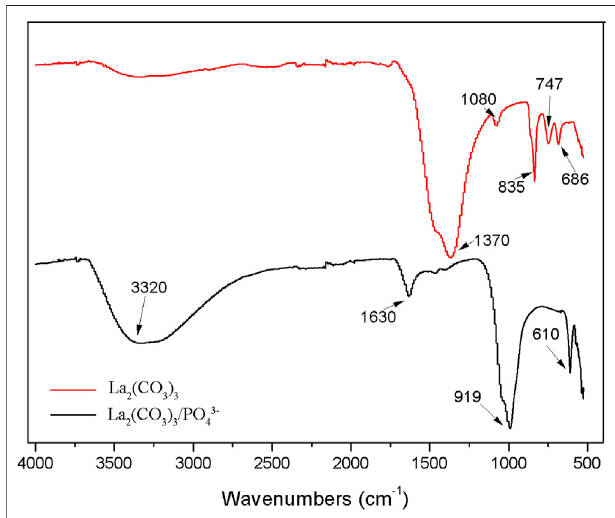
FIGURE 1 | FTIR spectrums of La 2 (CO 3 ) 3 and La 2 (CO 3 ) 3 /PO 43 − .